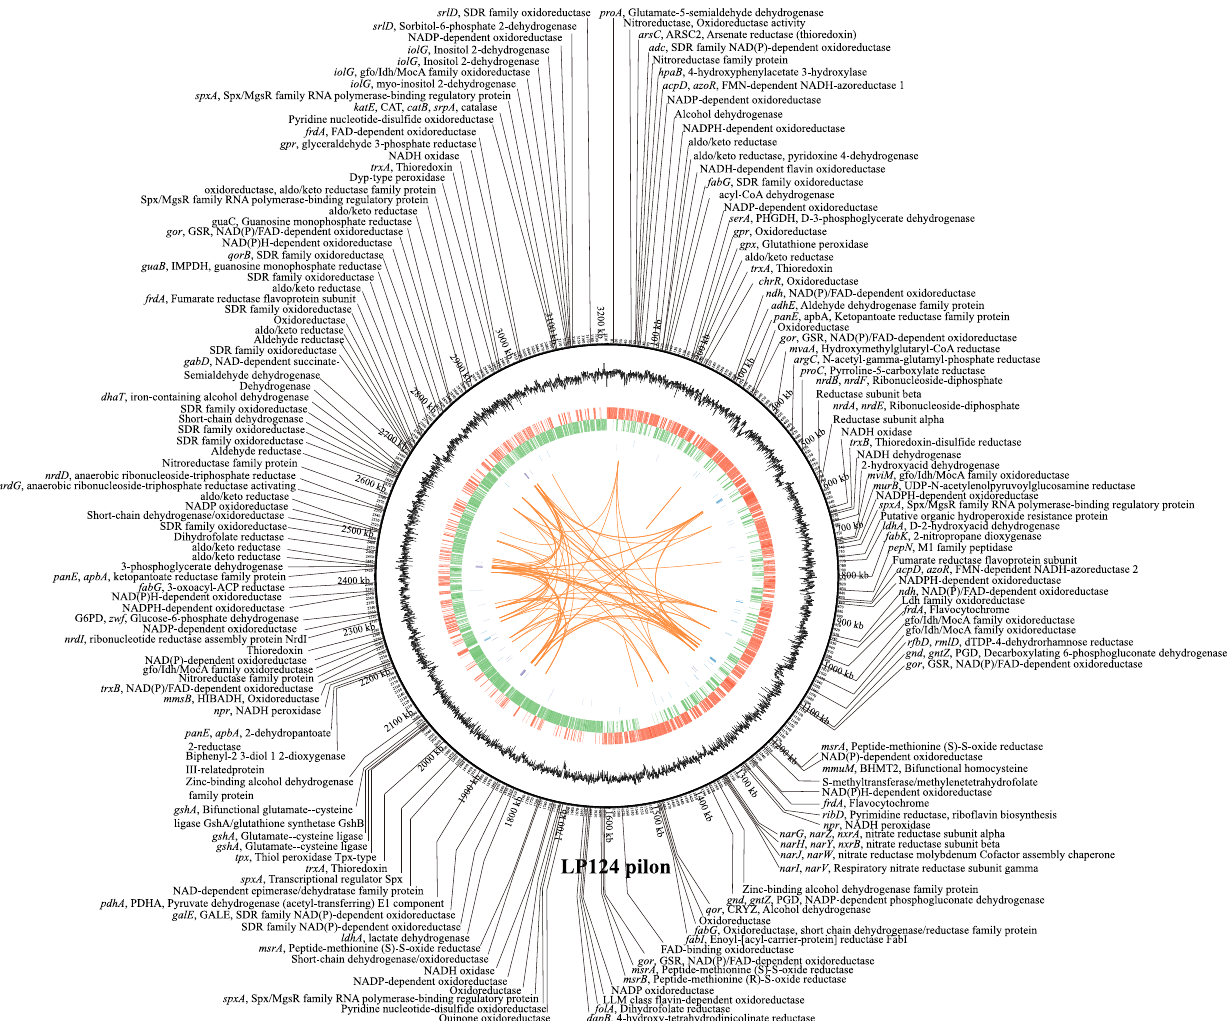
Fig. 6 Whole-genome analysis of Lactobacillus plantarum 124. LP124 genome circle map and oxidoreductase related genes. The coding genes were annotated with National Center for Biotechnology Information (NCBI) NR database by BLAST. From the outside to the inside: the fi rst circle is the genome location information, the second circle is the GC content information, the third circle is the coding gene on the positive chain (marked in red), and the fourth circle is the coding gene on the negative chain (marked in green), the fi fth circle is the ncRNA information on the positive strand (marked in blue), the sixth circle is the ncRNA information on the negative strand (marked in purple), and the seventh circle is the information of long repetitive sequences in the genome (marked in orange), the eighth circle represents genes related to